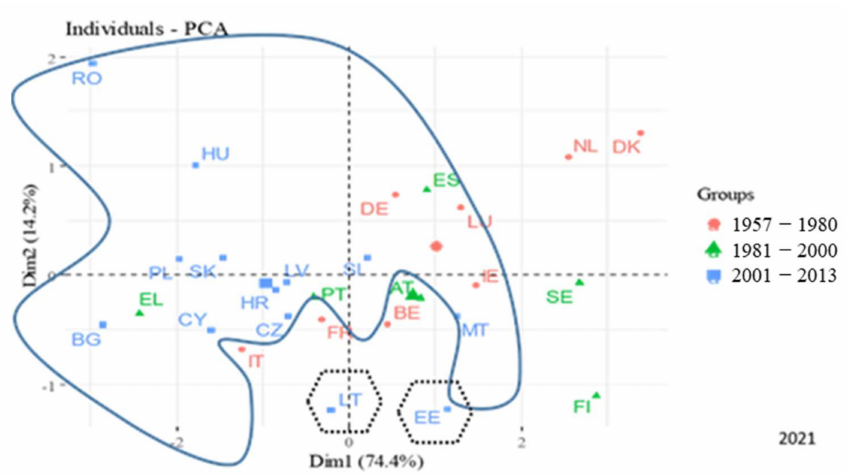
Figure 9. The position of countries on the plane of principal components, grouped by the year of joining the EU